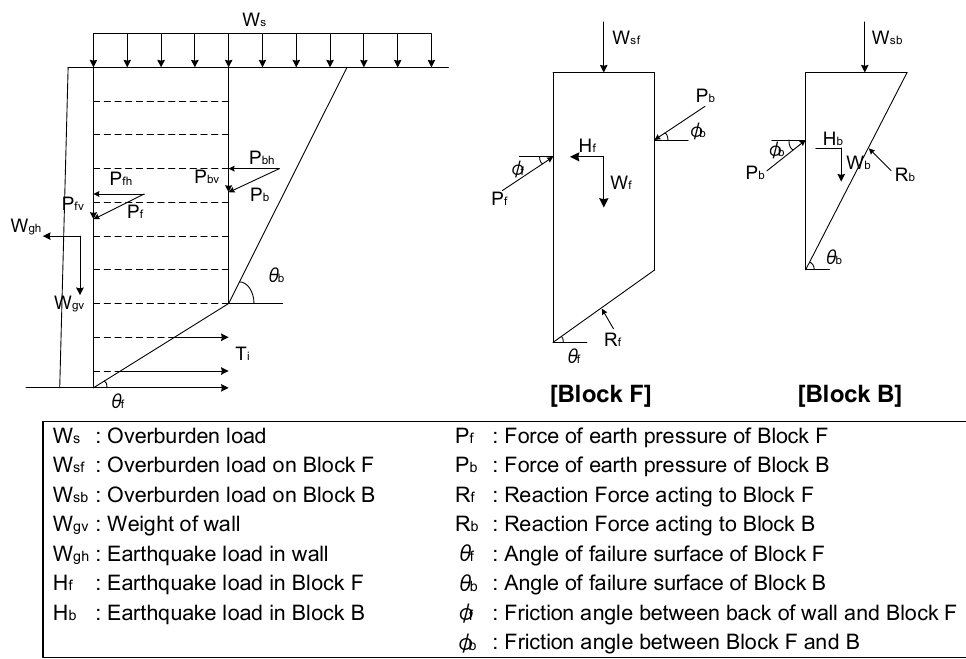
Figure 5. Two-wedge failure mechanism. Table 4. Safety factors of each section.